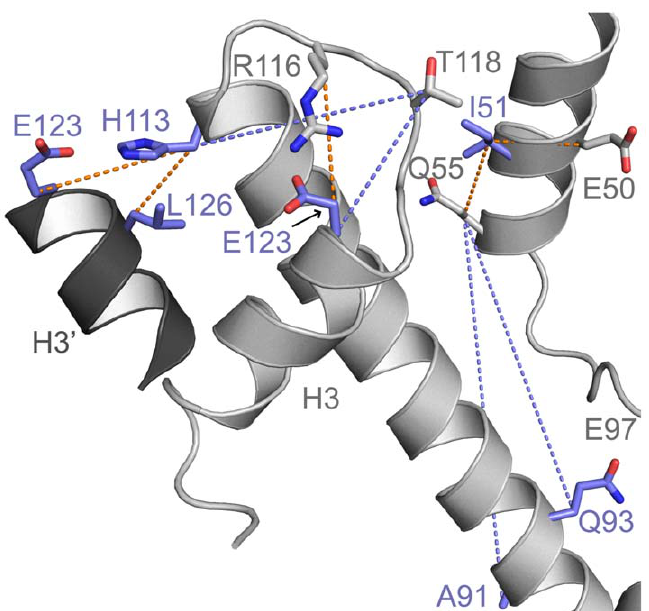
Figure 4. Coevolution of spatially remote and proximal pairs of residues in H3 suggest a function of the buried H3 residues independent of mediating stability. Significantly coevolving pairs of residues are shown in stick representation with dotted line between their C b atoms. Buried/interface residues are colored blue, while the rest of the protein is colored in grey and shown using the cartoon representation. The dotted lines between residues that are spatially proximal are colored orange, while the dotted lines between spatially distant residues are colored blue. The structure was rendered using PyMOL (http://www.pymol.org).